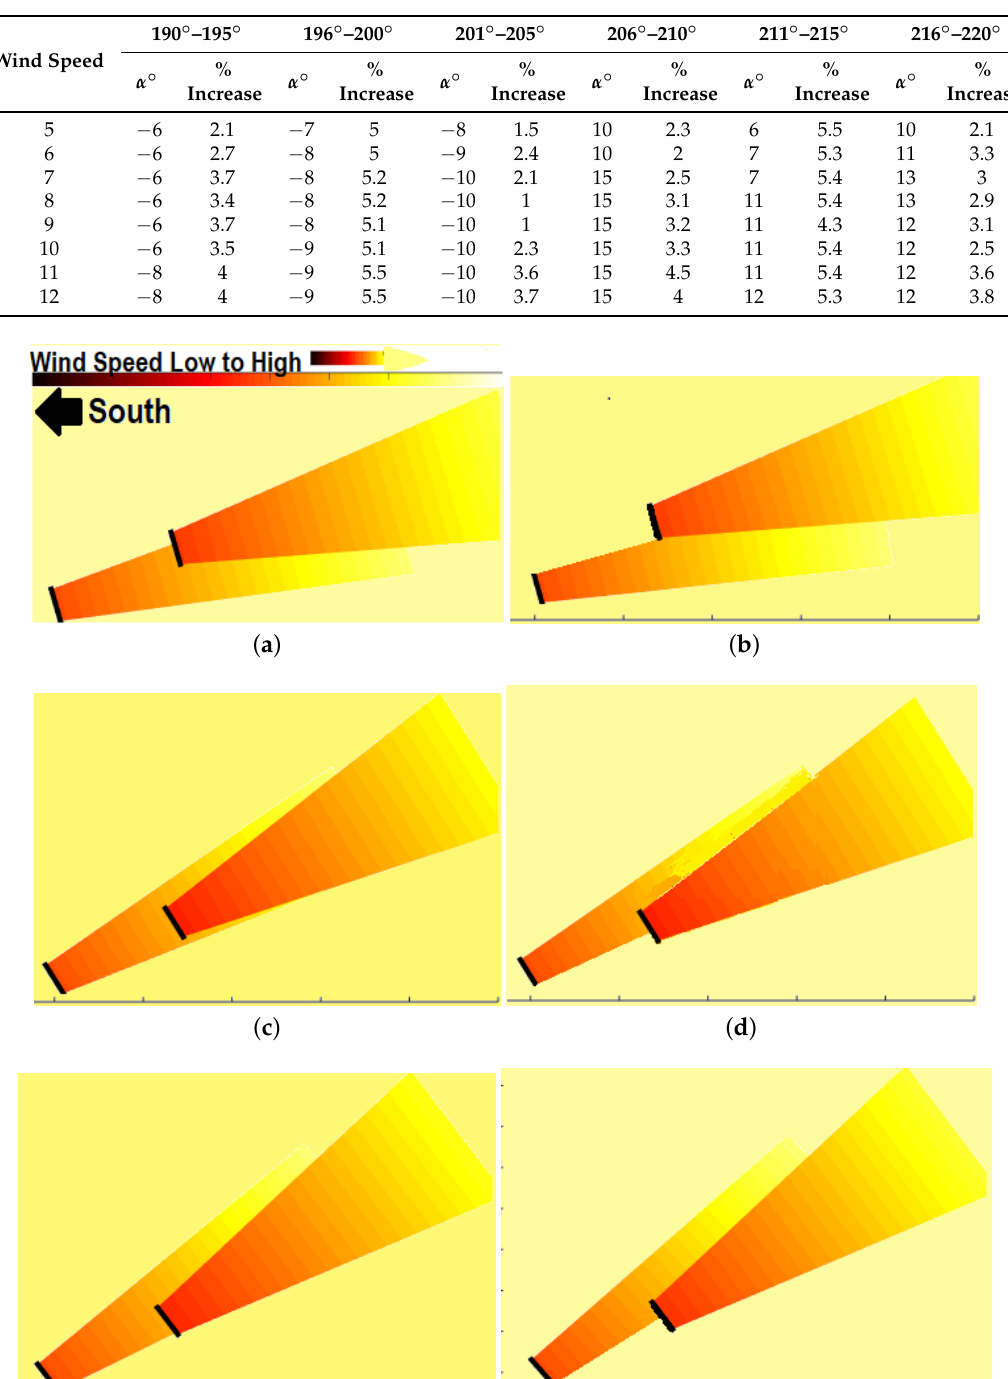
Table 3. Optimum α and % estimated simulated increase in production as compared to the greedy control.